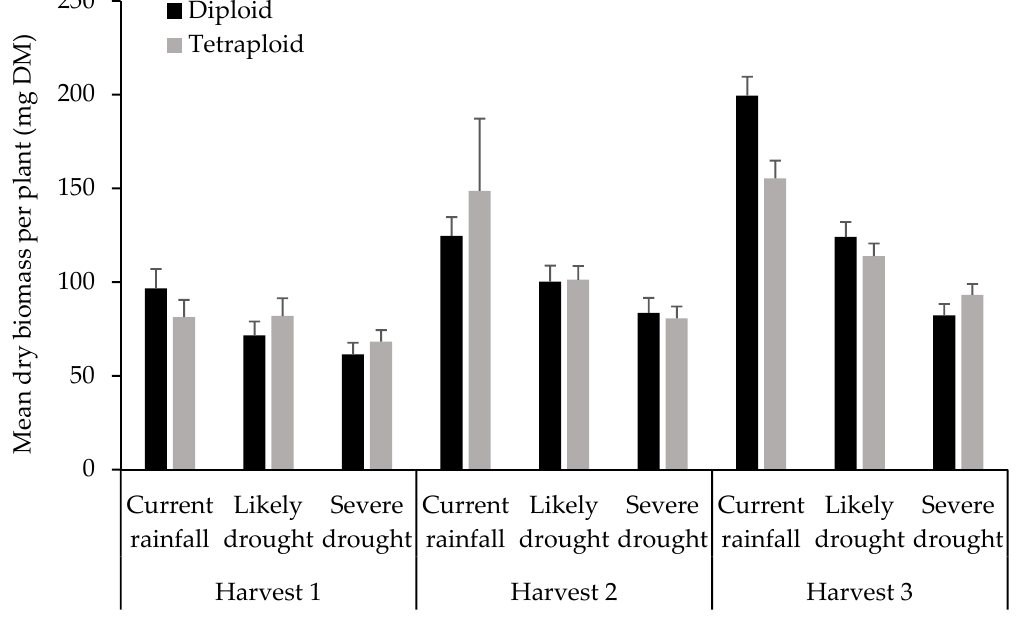
Figure 2. Mean dry biomass (with standard error bars) produced by diploids and tetraploids for all three harvests.